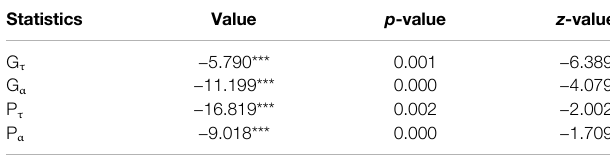
TABLE 4 | Panel cointegration